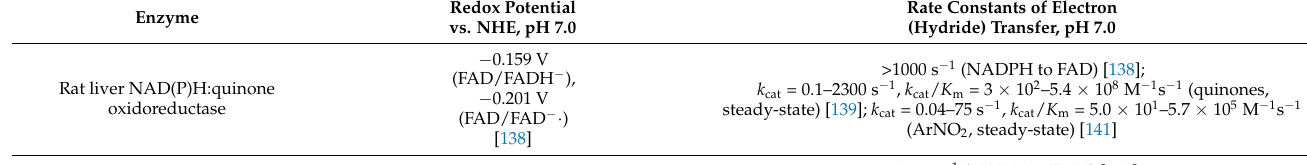
Table 3. Potentiometric and kinetic characteristics of mammalian NAD(P)H:quinone oxidoreductase and bacterial nitroreductases. Enzyme Redox Potential vs. NHE, pH 7.0 Rate Constants of Electron (Hydride) Transfer, pH 7.0 Rat liver NAD(P)H:quinone